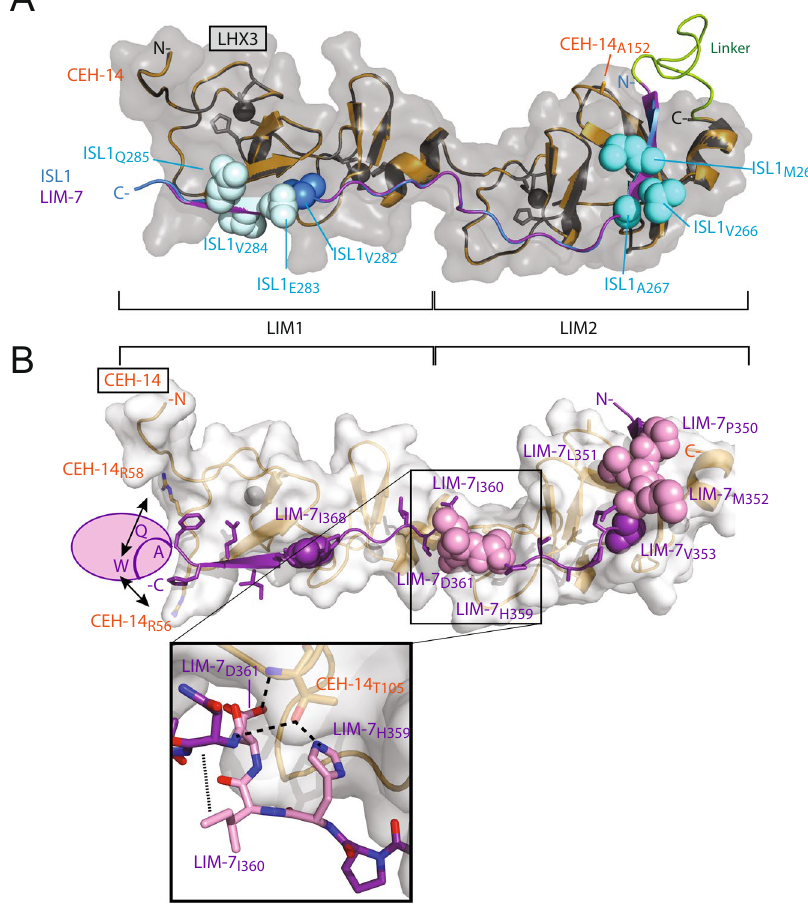
Figure 5. Conserved and unusual features of LHX3-Islet family LIM-HD interactions in C. elegans proteins. ( A ) Overlay of the LHX3 LIM1 + 2 (black ribbon/transparent grey surface representation)–ISL1 LID (cyan) crystal structure (1RGT Chain B) and a simple homology model of CEH-14(orange)–LIM-7(purple). The N- and C-termini from the domains in LHX3 and ISL1 are indicated. A small insertion in CEH-14 (residue A152) is likely to have little effect apart from a short β -hairpin extension. The binding hotspots for ISL1 for LHX3 and LHX4 as determined by alanine scanning mutagenesis and Y2H are shown (cyan spheres), an additional hotspot for ISL2 binding to LHX3 and LHX4 is also indicated (light cyan spheres) and a conserved residue (ISL1 V282 ) that is buried between the two zinc binding modules is indicated (blue spheres). ( B ) Predicted binding features of CEH-14 (orange ribbon; white surface representation) and LIM-7 (purple ribbon and stick representation). The binding hotspots are indicated (pink circles/spheres). LIM-7 V353/I368 (purple spheres) are buried between the two zinc binding modules of each LIM domain in CEH-14. Inset shows possible stabilising interactions within the main hotspot with residues in stick representation. Possible stabilising interactions between LIM-7 W376 and CEH-14 R56/R58 are indicated. Nitrogen atoms (blue) and oxygen atoms (red) are shown where